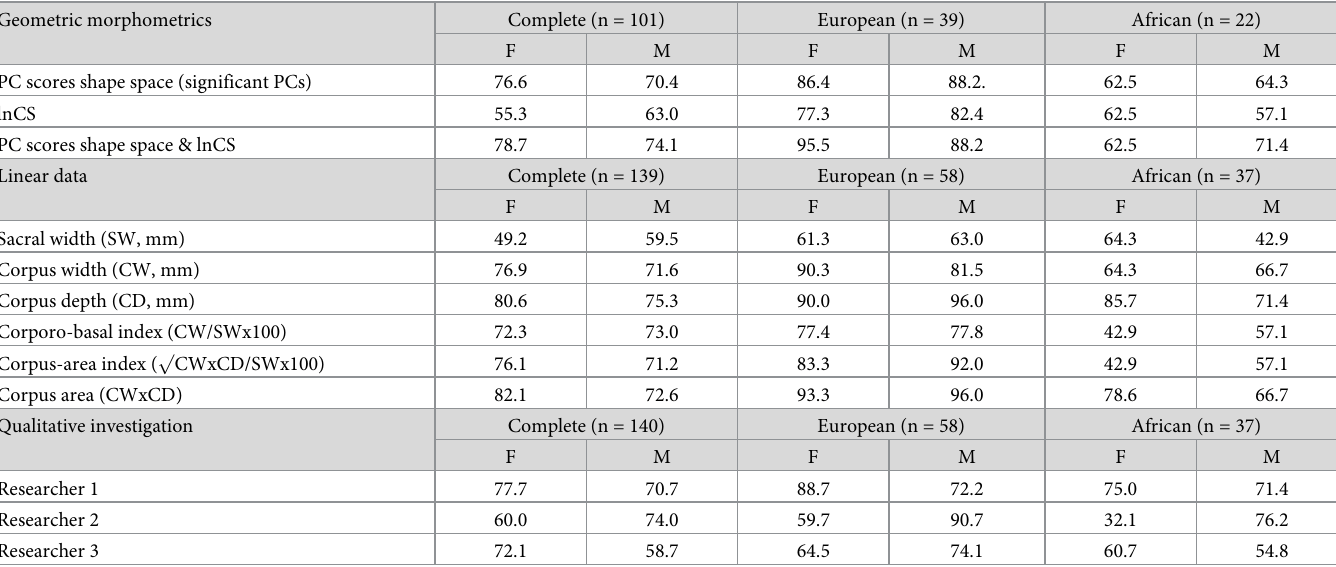
Table 6. Percentages of cross-validated correct